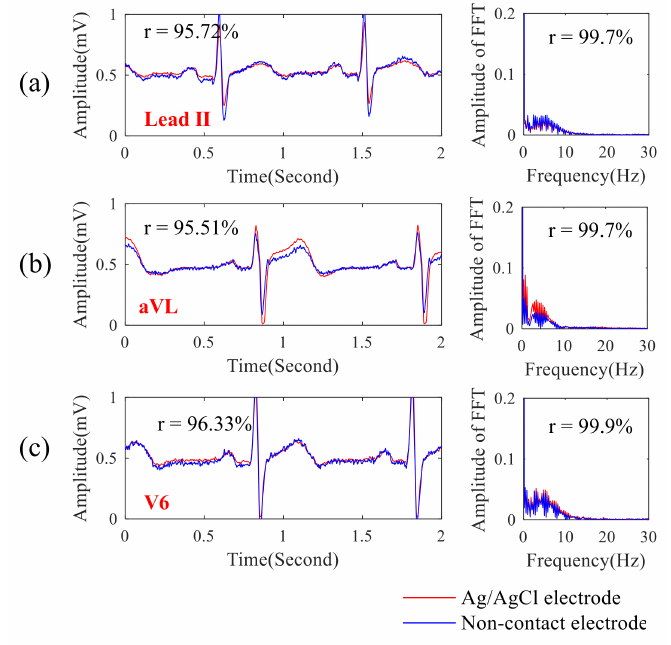
Figure 6. Comparisons between the ECG signals and their spectra obtained by different electrodes: ( a ) lead II, ( b ) aVL, and ( c )